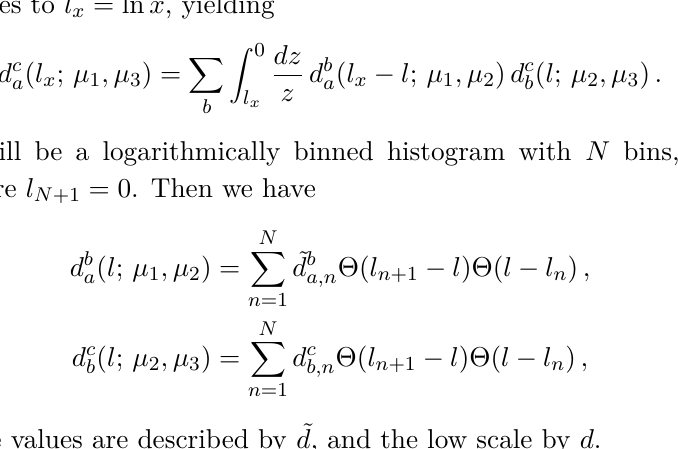
Figure 15 . The coefficient of δ (1 − x ) associated with d γ generally, a number of δ -function coefficients can be accessed in the public code, in addition to the continuum